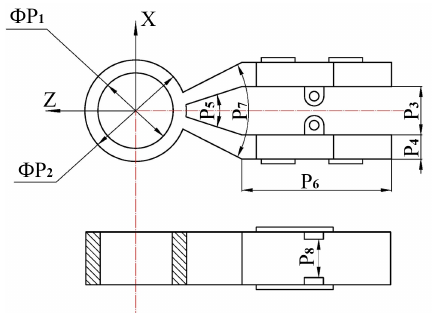
Figure 9. Structural dimension parameters of the